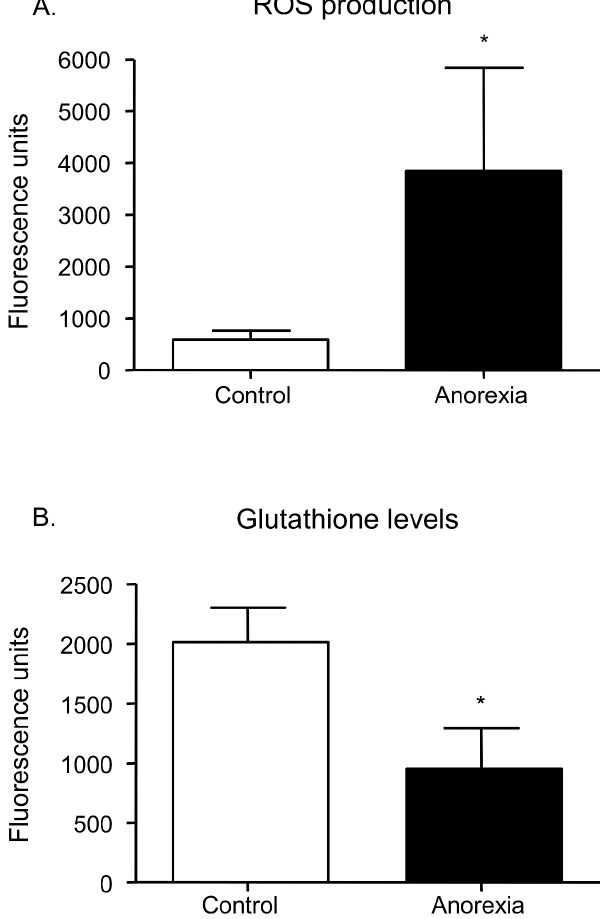
Figure 2. Effect of anorexia on ROS production (A), measured by DCFH fluorescence, and on GSH content (B), measured by CMFDA fluorescence. n=20 per group. *P , 0.05 vs. controls.